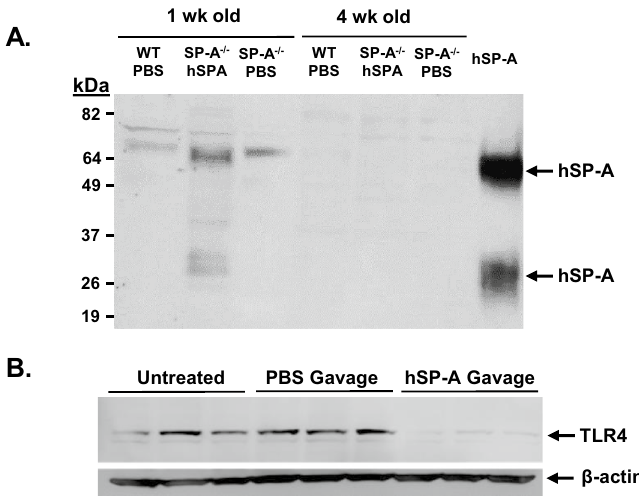
Figure 3. Impact of orogastric gavage of neonatal SP-A −/− mice with purified SP-A. ( A ) Western analysis to detect the presence of SP-A was performed on 1 week and 4 week old WT and SP-A −/− mice 2 h after gavage with 50 µg of purified SP-A. ( B ) 1 week old SP-A −/− mice that were untreated, gavaged with PBS or with 5 µg of purified SP-A in PBS on day 4 and day 6 of life. Shown is Western analysis of TLR4 and β-actin protein in the ileum of 3 mice from each treatment regimen. Figure created using SigmaPlot, ver 14, www.systa tsoft